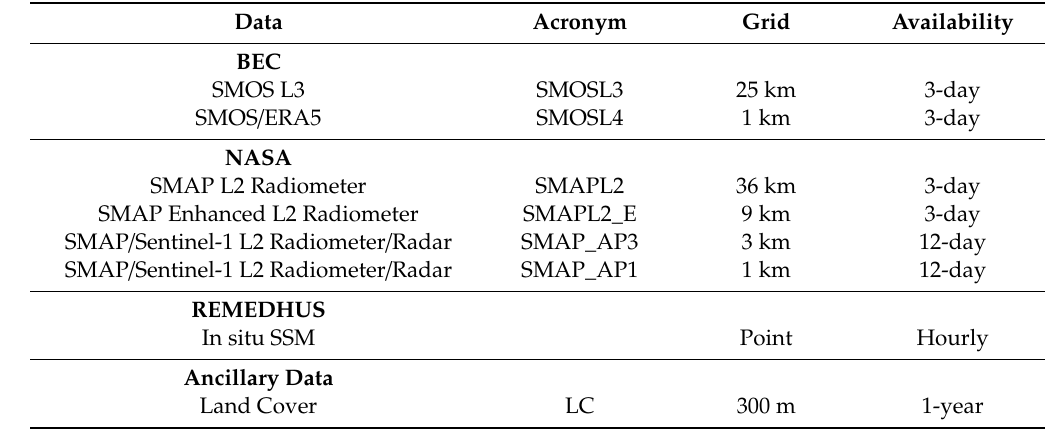
Table 1. Summary of the data products used in this